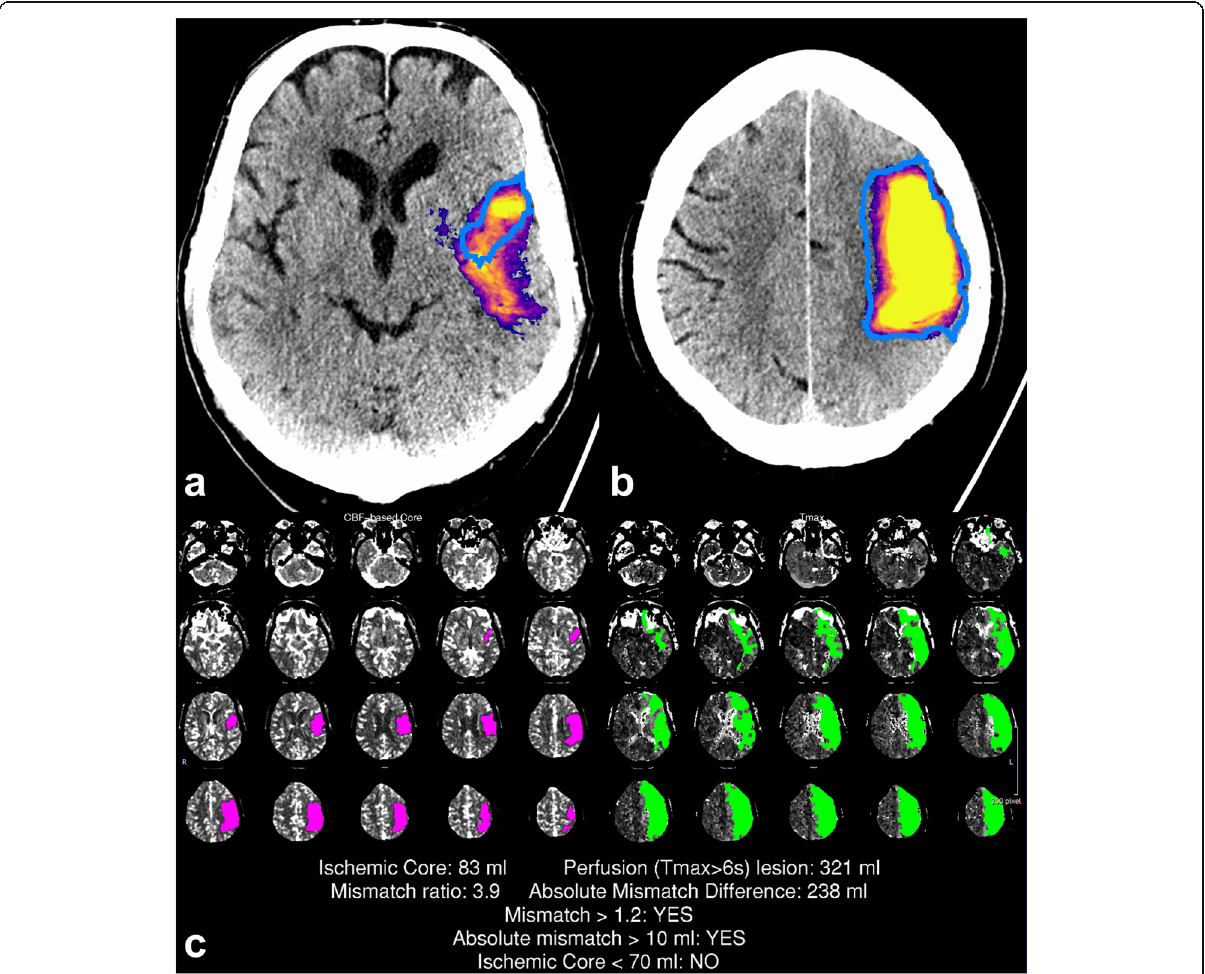
Fig. 2 A large infarct correctly detected by the convolutional neural network (CNN). The CNN prediction included the final infarct (blue outline) and a part of the penumbra. Representative slices of the CNN predictions ( a , b ) with corresponding computed tomography perfusion RAPID (CTP-RAPID) report for comparison ( c ). The purple-orange-yellow colourmap depicts CNN output probability. Reported volumes: